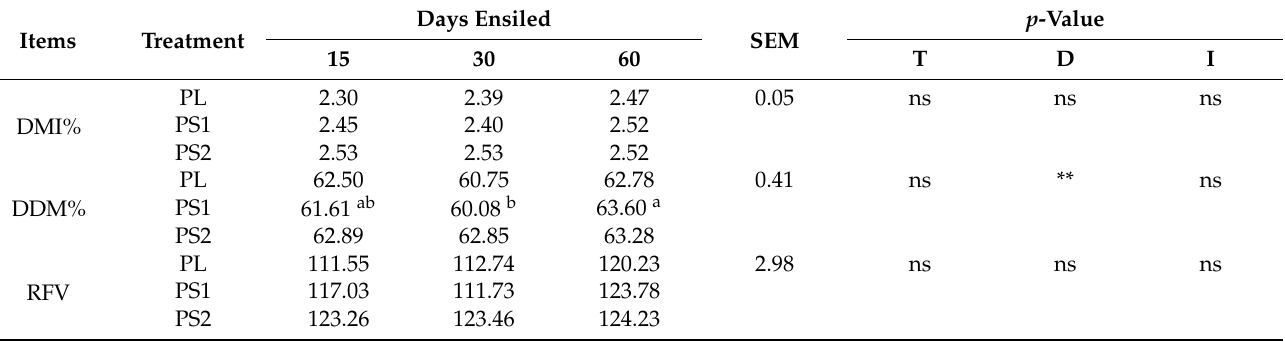
Table 3. Relative feed values of kudzu